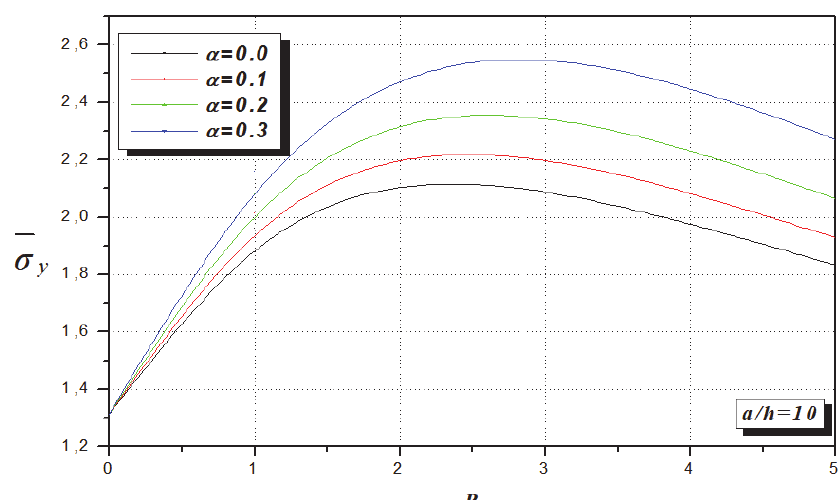
Figure 8: Variation of stress non-dimensional as a function of the power index P and the different porosity factor α of sandwich plate FGM.